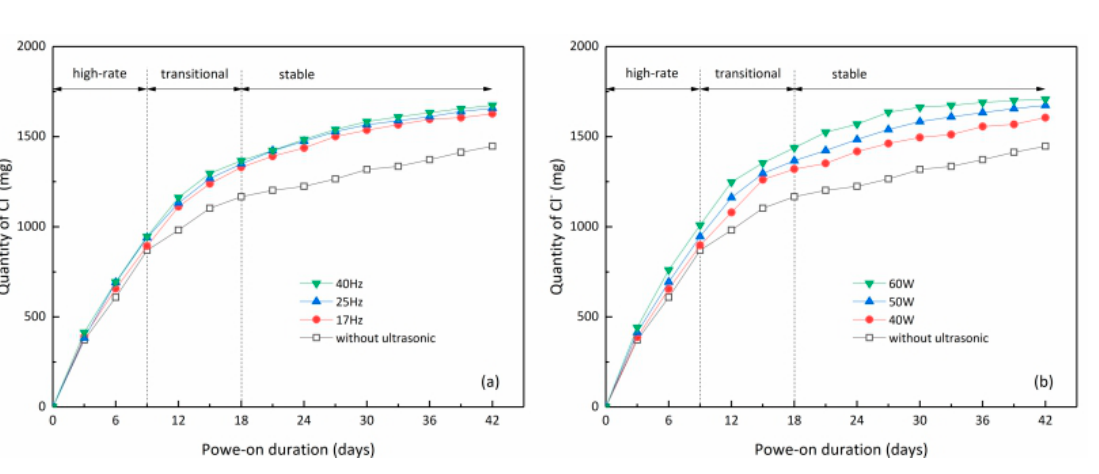
Figure 4. Variation of chloride ion discharge with time in ECR process under different ultrasonic parameters: ( a ) different ultrasound frequencies, ( b ) different ultrasound powers.